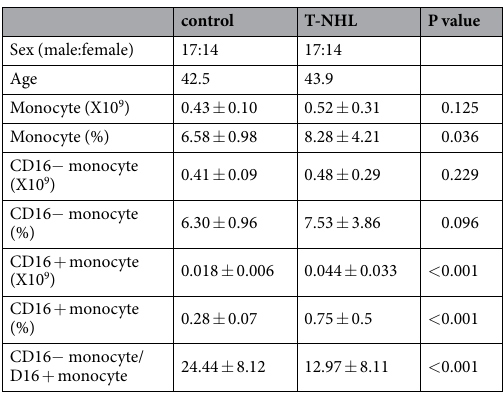
Table 2. The number of monocyte subsets in T-NHL patients and the health